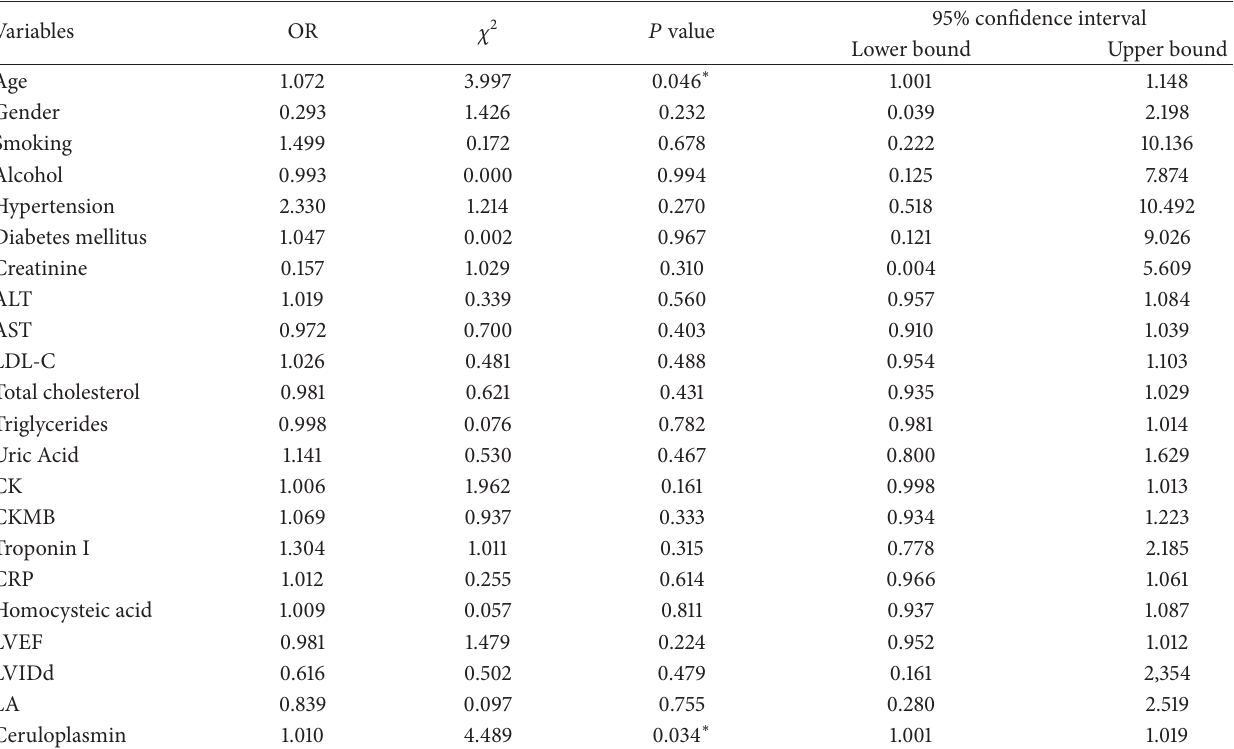
Table 4: Relationship between extent of heart failure and clinical and laboratory parameters in patients with nonischemic cardiomyopathy.